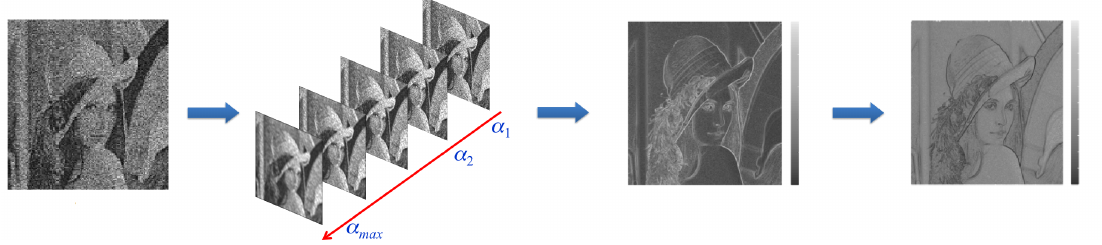
Figure 3. Example of the EWF contribution to the Lena picture. Moving from the left to the right: noisy image, Wiener filtering step providing K α -solutions, ˆ θ MAP , and α MAP